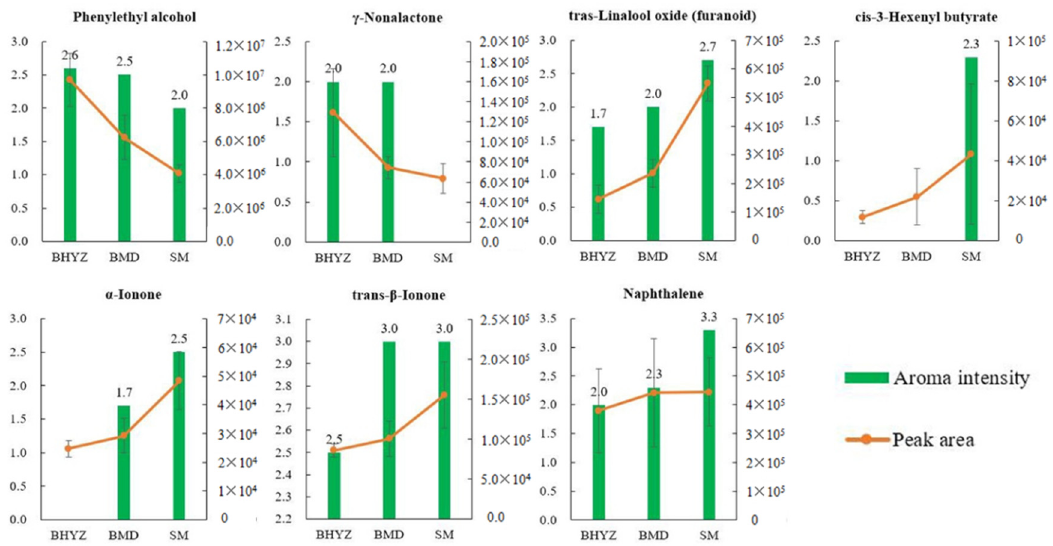
Figure 6. Distribution on the aroma intensity and content of key odorants accounting for the aroma characteristics of white teas.